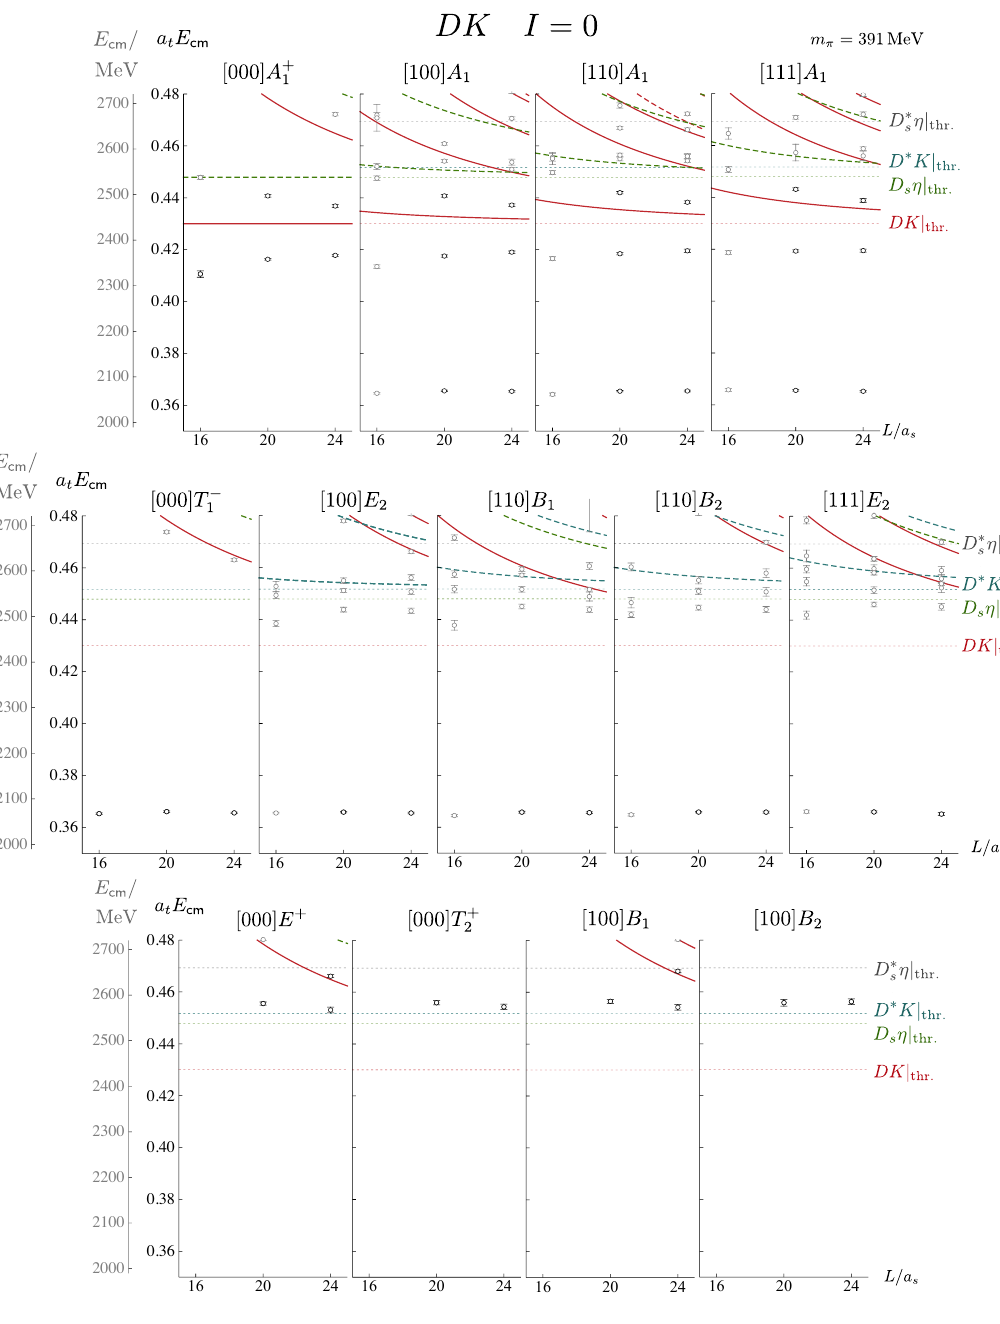
Figure 4 . As figure 3 but for I = 0 DK on the m π = 391 MeV